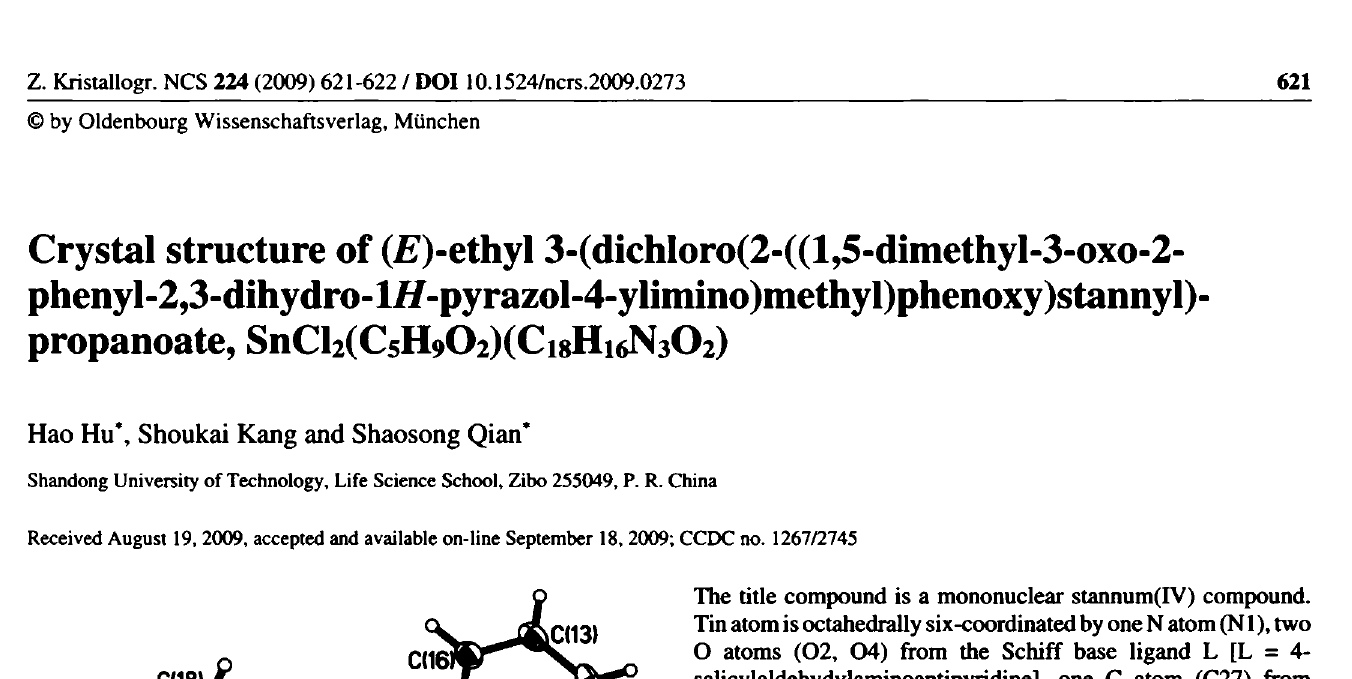
Table 1. Data collection and handling.